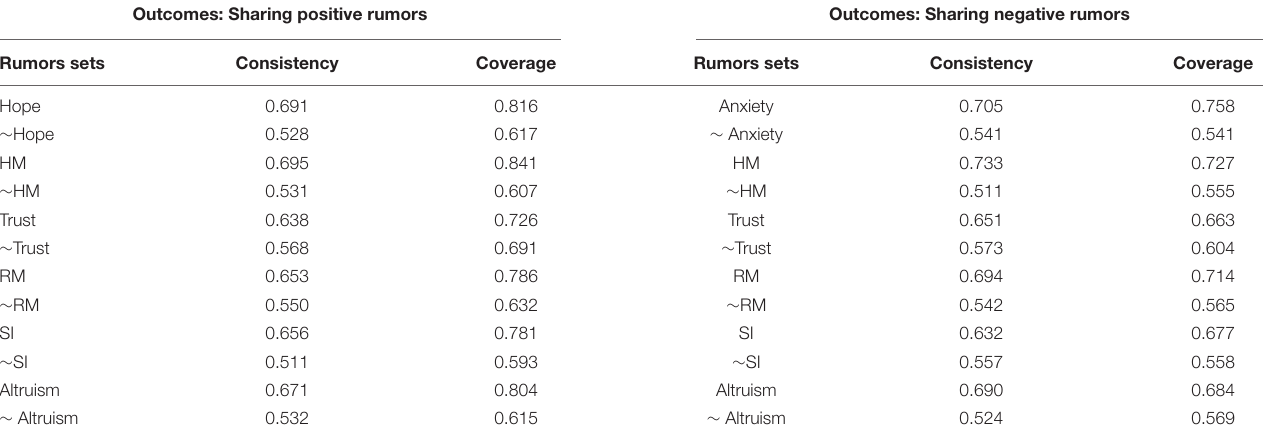
TABLE 3 | Outline of necessary conditions required for sharing positive and negative